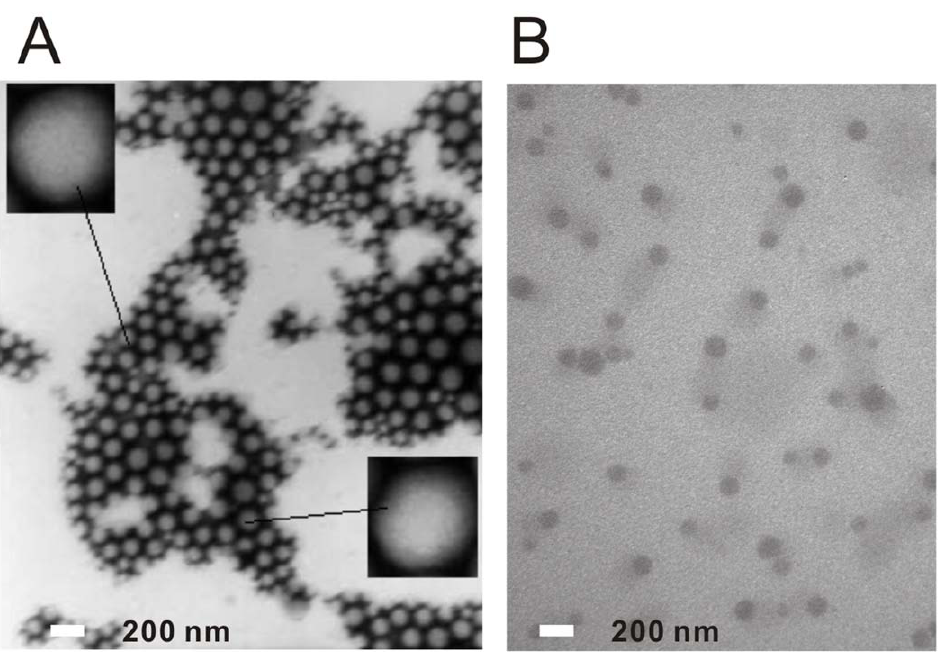
Figure 3. TEM image of the CLGNs. (A) negative stained by phosphotungstic acid and (B) gluocoseamylase immobilized CLGNs prepared by adsorption